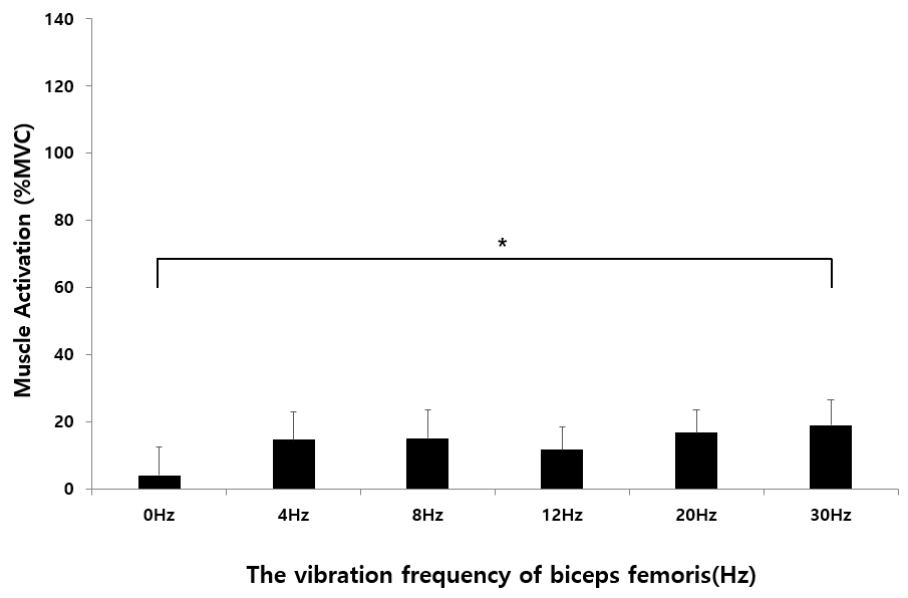
Figure 4. Results of biceps femoris muscle activation according to vibration frequency conditions (* p < 0.05,).